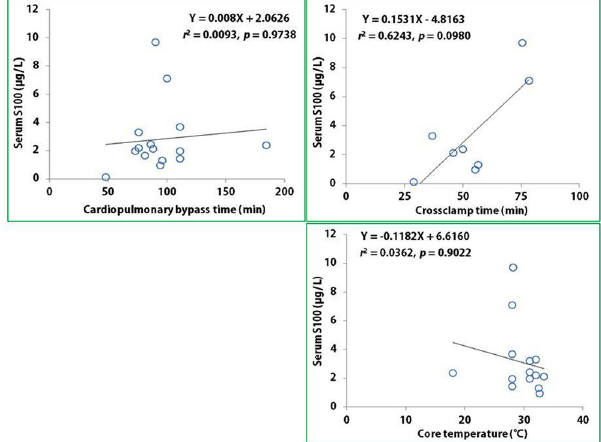
Fig. 7 - Linear correlation analysis between serum S100 concentration at T and cardiopulmonary bypass, crossclamp time and core Fig. 5 - An inter-subgroup comparison of serum S100ß at T and T . 2 2 7 temperature. CABG=Coronary artery bypass; CHD=Congenital heart defect; DHCA=Deep hypothermia circulatory arrest; FCD=Functional cerebral damage; MMH=Mild-moderate hypothermia; ΔS100ß could be calculated in 51 series of patients. The peak NM=Normothermia; OCD=Organic cerebral damage; OPCAB=Off- values were present at T in 5 (9.8%), T in 36 (70.6%) and T pump coronary artery bypass; T =At the end of cardiopulmonary 1 2 3 2 in 10 (19.6%) patient cohorts, respectively ( χ 2 =48.9, P bypass; T =24 hours after cardiopulmonary bypass 7